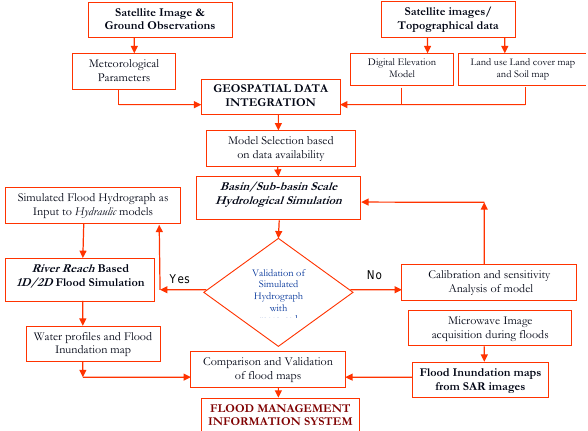
Fig. 3.8. Integrated flood modelling and management information system framework (modified after